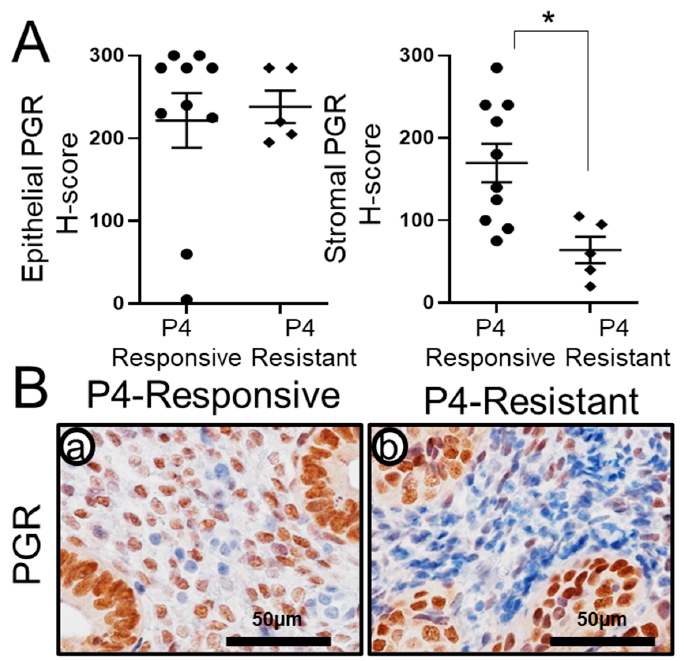
Figure 3. Stromal PGR expression is upregulated in P4-responsive women after P4 treatment. ( A ) H-score of PGR showed that stromal PGR expression is significantly higher in P4-responsive women (n = 10) compared to P4-resistant women with CAH or EEC (n = 5) after P4 treatment. ( B ) Repre- sentative PGR expression in P4-responsive (a) and P4-resistant (b) women by immunohistochemis- try. *, p < 0.05.